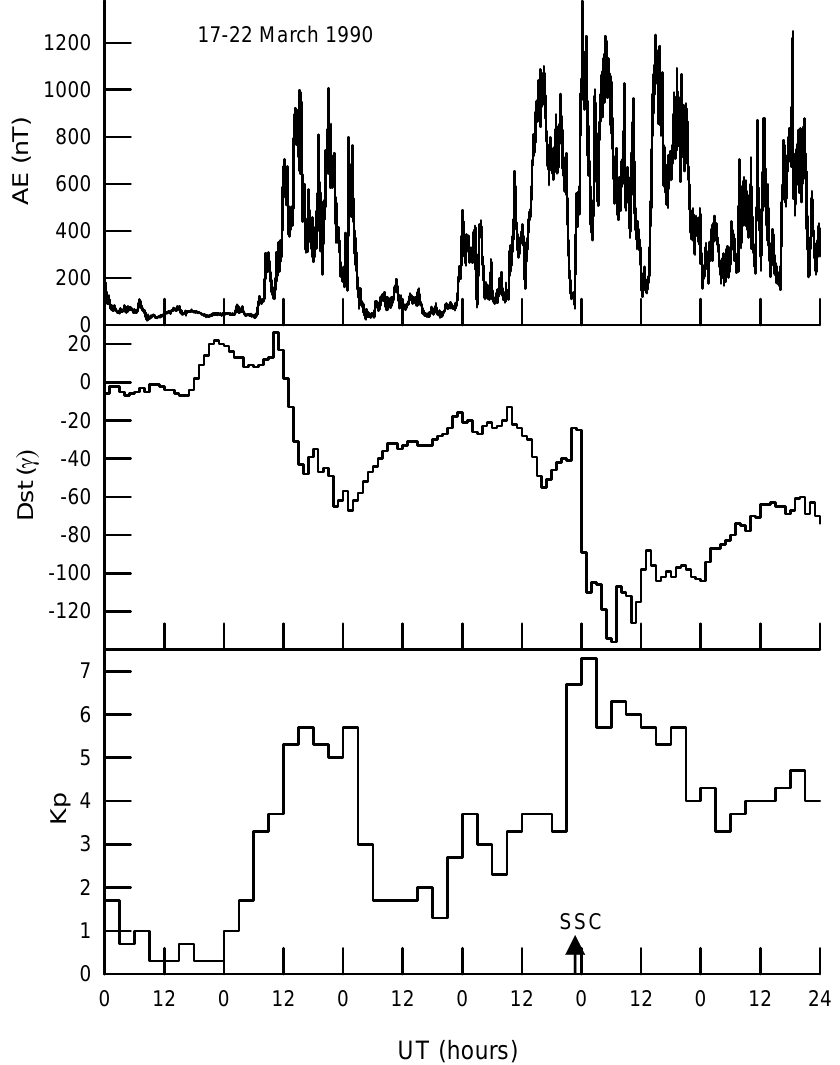
Fig. 1. The variation in the AE index (top panel), the Dst index (middle panel), and Kp index (bottom panel) during 17–22 March 1990. The SSC onset of the second geomagnetic storm is shown by the arrow in the bottom